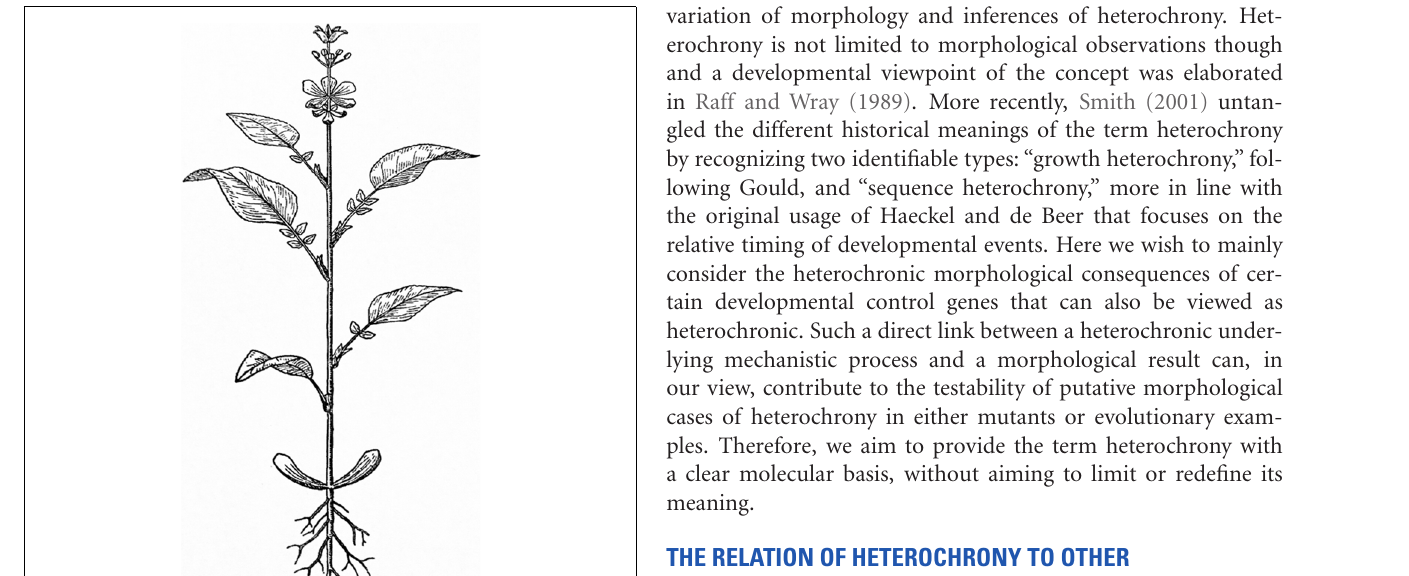
to regular time or relative to other developmental events (Poethig, 2003). Developmental time or, e.g., plastochron length in case of leaves, is the time that passes between the development of two suc- cessive leaves. Developmental rate in plants is counted in numbers of organs that develop per unit of time. Plants are special in this sense because developmental rate can be easily measured in the adult form of the plant as an average number of organs that has developed in a certain period of time, which makes plants a good system to study developmental